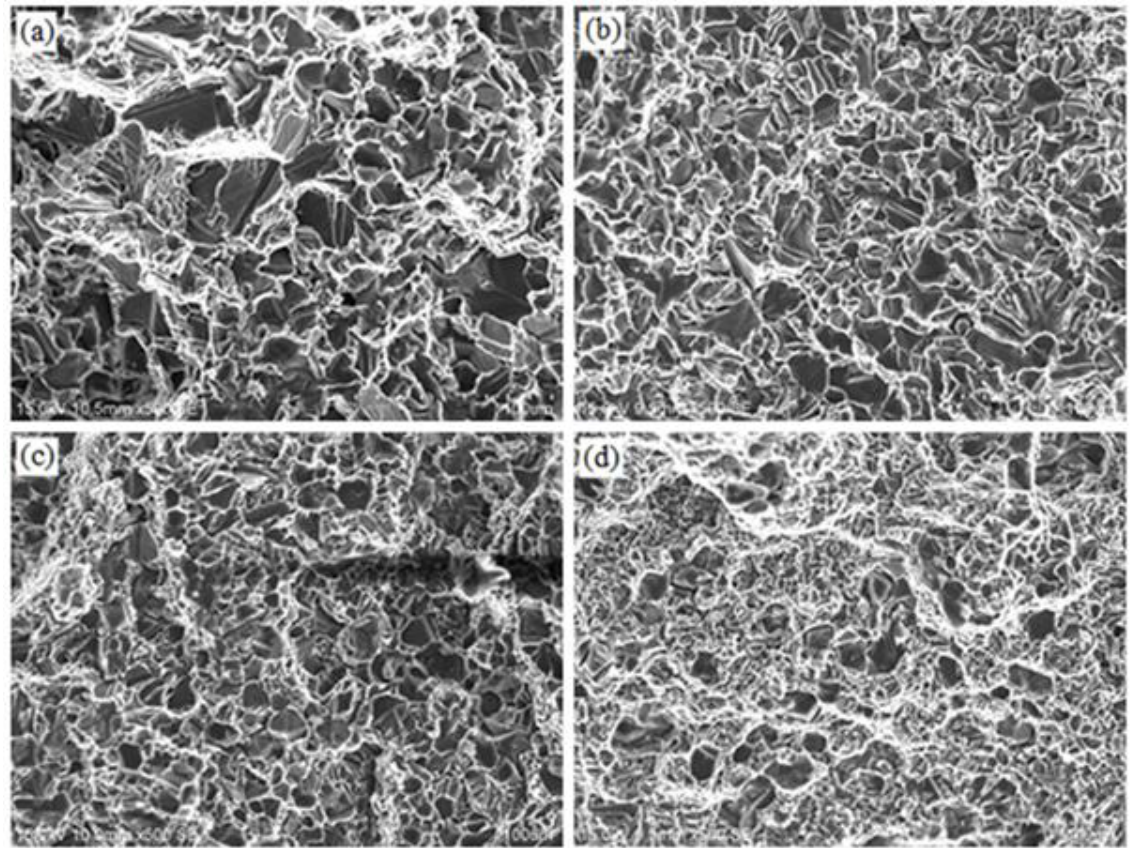
Fig. 5. SEM micrographs, illustrating the Al–15%Mg 2 Si composites fracture surfaces before (a and c) and after (b and d) heat treatment with Gd concentration of: (a) and (b) 0wt%, (c) and (d)